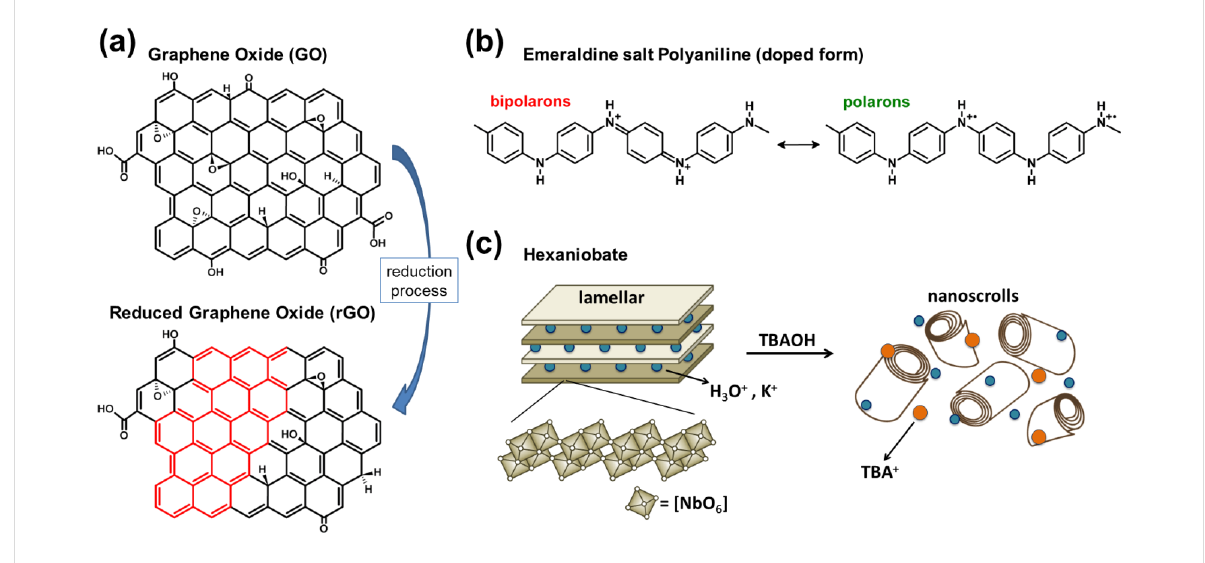
Figure 1: Schematic representation of (a) graphene oxide and reduced graphene oxide structures, (b) polaron and bipolaron segments of emeraldine salt polyaniline (doped form), and (c) hexaniobate in layered and nanoscroll morphologies. TBAOH: tetra( n -butyl)ammonium hydroxide, TBA + : tetra( n - butyl)ammonium